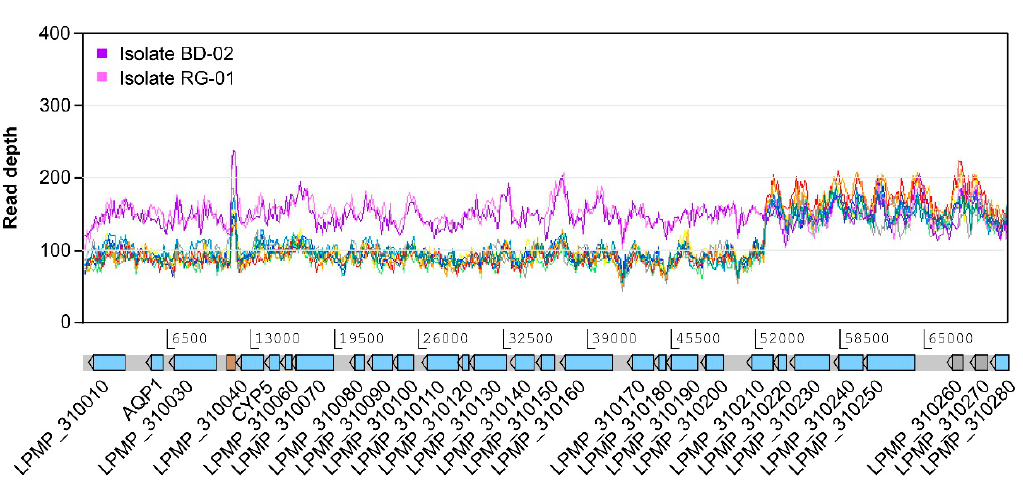
Figure 4. Relatively large subtelomeric deletion on chromosome 31. This deletion is estimated to be present in approximately half of the copies of this chromosome, spanning a region of 52 kb and affecting 20 protein-coding genes, including the one encoding aquaglyceroporin AQP1. The deletion is present in the PSC-1 reference strain even before exposure to Sb III , but it is not apparently present in clinical isolates BD-02 and RG-01. Except for those used for the isolates, colors in this figure follow the conventions used in Figure 3. CYP5: cyclophilin 5.